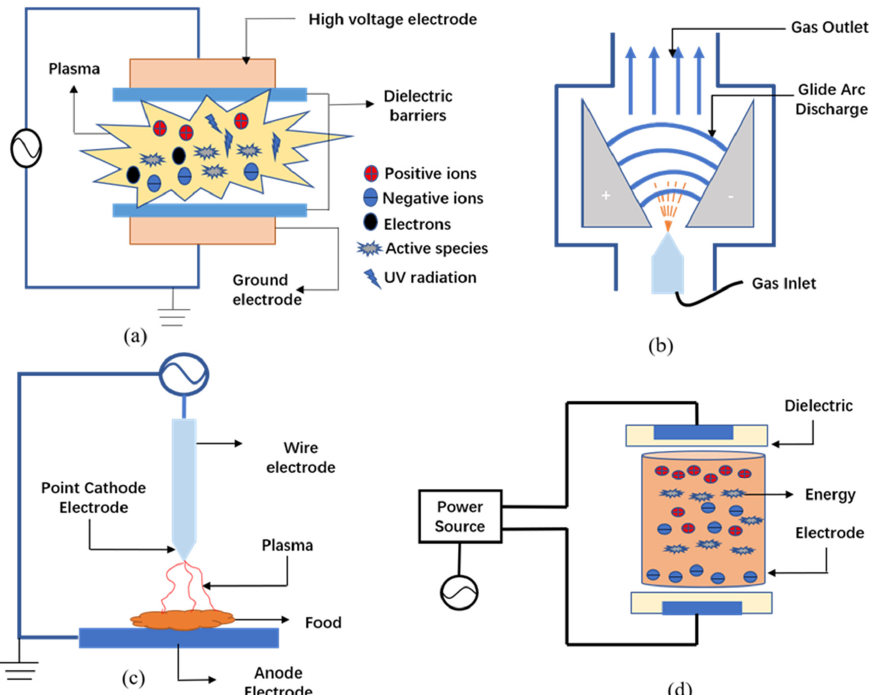
Figure 2. Schematic diagram of various equipment for generating plasma [16]. ( a ) dielectric barrier discharge, ( b ) corona discharge, ( c ) glow discharge, ( d ) glide arc discharge.